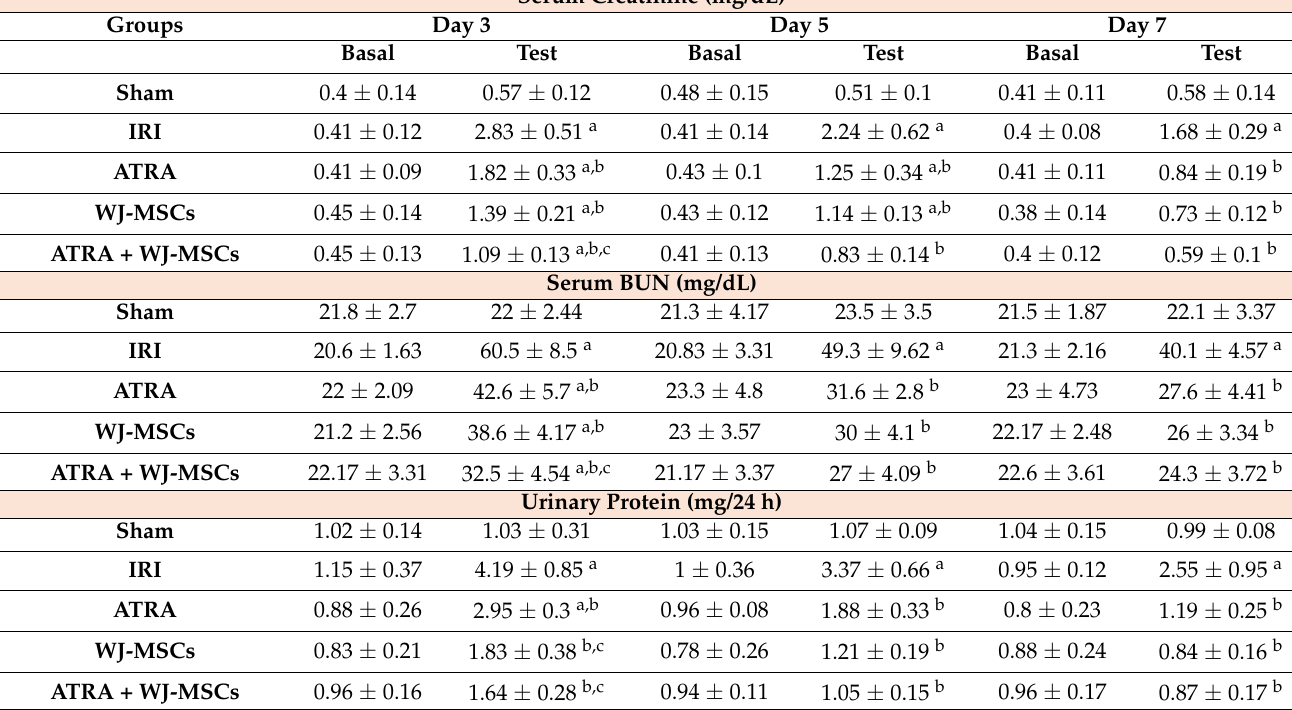
Table 1. Effect of pretreatment of WJMSCs with ATRA on serum creatinine (SCr), serum BUN and urinary protein excretion (g/24 h) at 3, 5 and 7 days (n = 6/group). Serum Creatinine